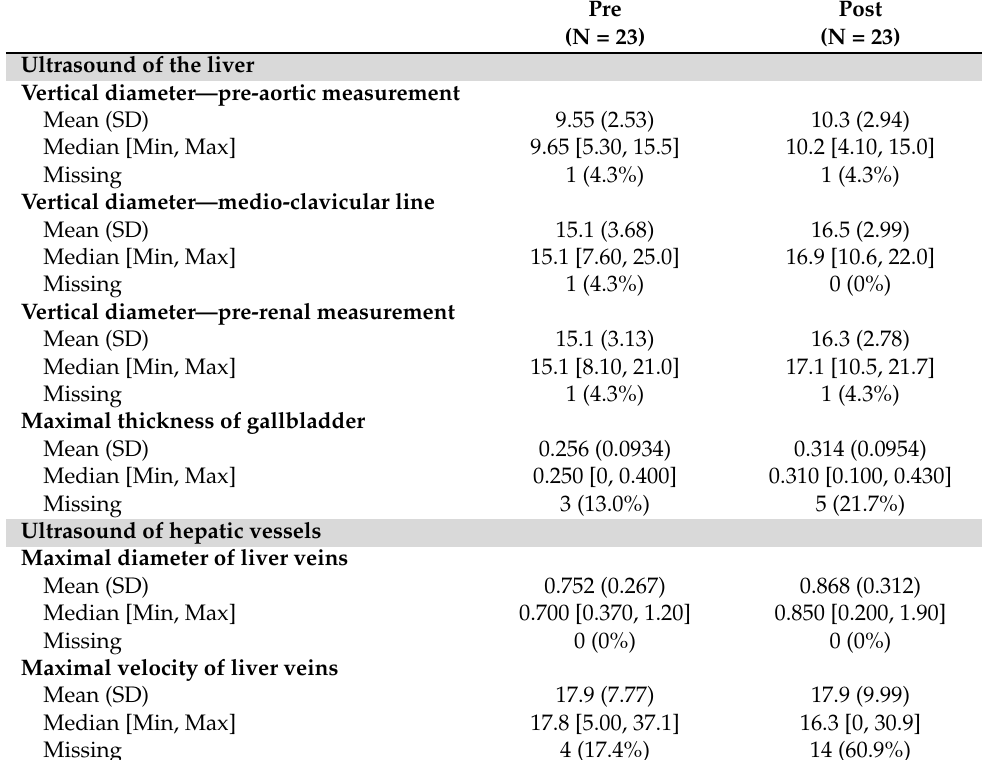
Table 3. Sonography